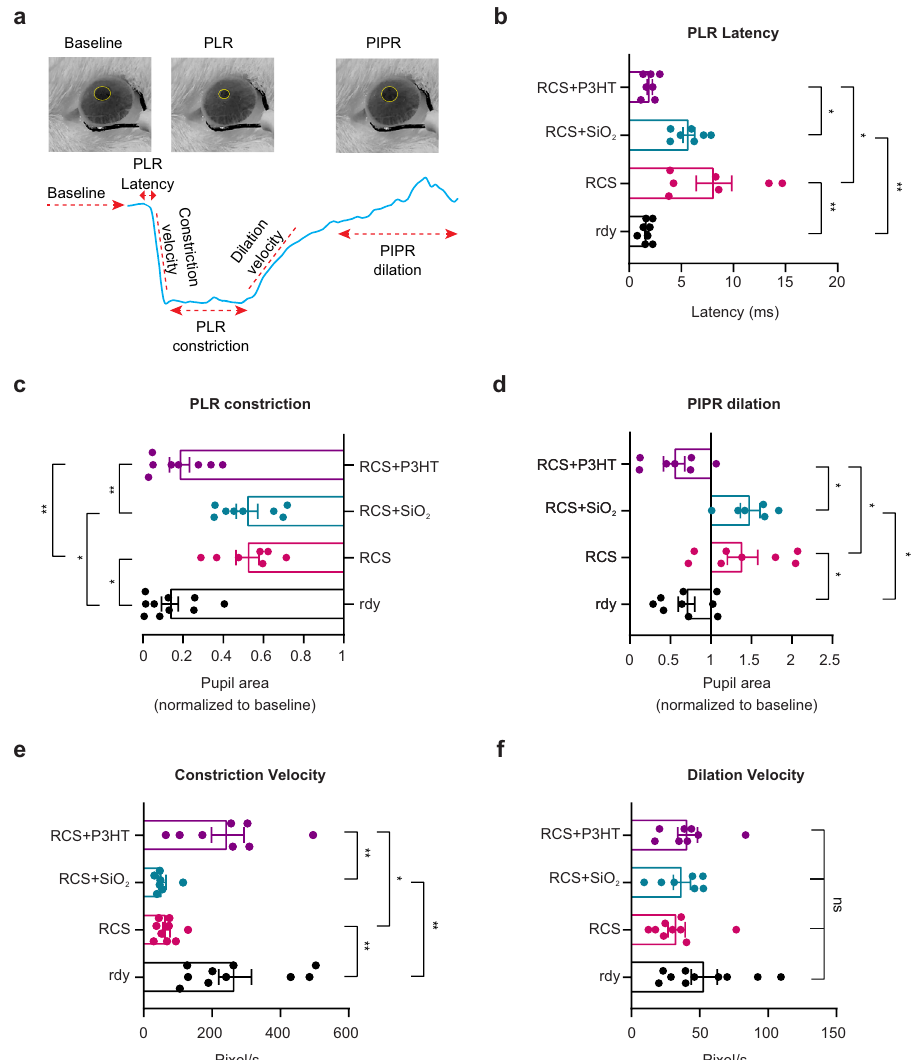
Fig. 4 The pupillary light re fl ex is fully rescued by P3HT-NPs in aged RCS retinas. a Top: The Pupillary Light Re fl ex (PLR) and Post-Illumination Pupillary Response (PIPR) were video recorded under infrared illumination in response to a prolonged stimulus (20 sec) of green light (530 nm) of 20 lux. Representative images of the pupil ’ s maximal constriction are shown. Bottom: From the recorded video, we extrapolated: (i) the area of the pupil at baseline (before the light stimulus); (ii) the latency of the pupil constriction from the switch of the light to the start of pupillary constriction; (iii) the constriction velocity computed as the minimum fi rst derivative value calculated during the constriction; (iv) the PLR constriction, as the average area of the pupil during the constriction normalized to the baseline area; (v) the dilation velocity, as the maximum value of the fi rst derivative computed during the dilation phase; and (vi) the PIPR dilation, as the average area of the pupil during relaxation normalized to baseline. b – f Aged-matched (13/15-month-old) rdy, RCS, RCS + SiO 2 and RCS + P3HT were analyzed for PLR latency (ms, b ), PLR extent of constriction ( c ), PIPR dilation ( d ), constriction velocity ( e ), and dilation velocity ( f ). RCS + P3HT animals performed like healthy rdy controls, with shorter constriction latency, a more intense pupillary constriction and a smaller relaxation than untreated RCS or sham-injected RCS rats. Kruskal – Wallis/Dunn ’ s tests. Sample size: PLR Latency (7,8,7,7), PLR constriction (10,7,8,8), PIPR dilation (9,8,7,7), Constriction velocity (10,9,7,8), Dilation velocity (10,9,7,8) for rdy, RCS, RCS + SiO 2 and RCS + P3HT, respectively. Data are the means ± sem with individual experimental points. * p < 0.05, ** p < 0.01. For exact p -values and source data, see Source data fi Light-driven behavioral responses are restored in aged dys- trophic RCS rats injected with P3HT-NPs . We next tested whether the rescue of cortical responses to light was re fl ected by the light-driven behavioral responses that rely on the innate aversion of rodents to illuminated areas and related anxiety 13,49 .